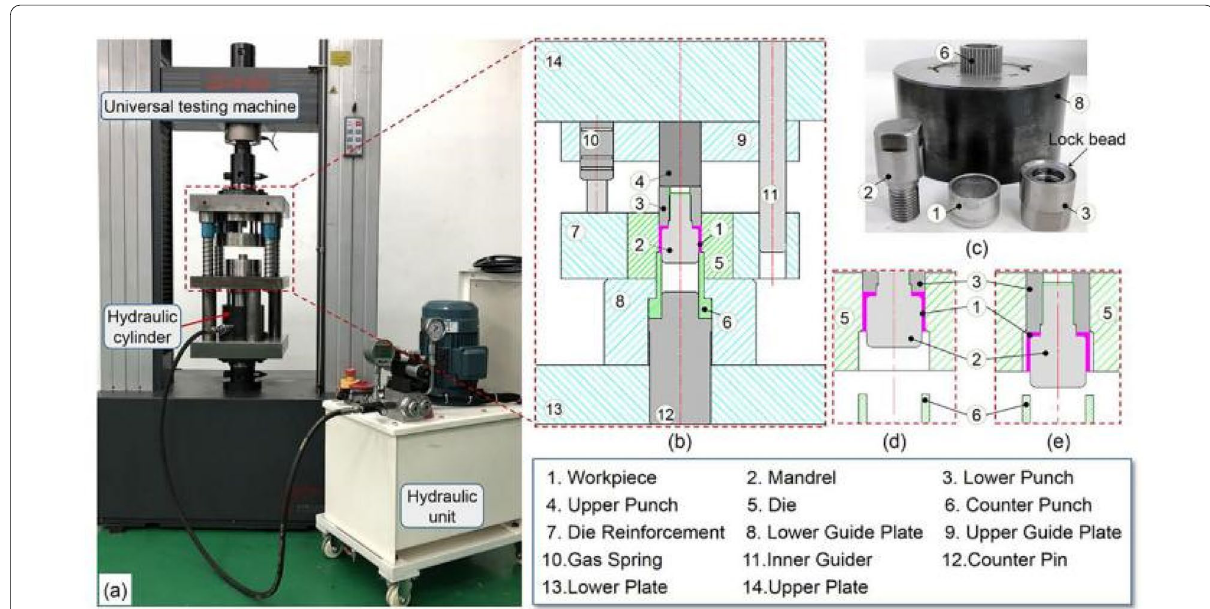
consistent with the experimental conditions, as shown in Figure 8. The stroke of the punch in the U-CDZ method was denoted as S 1 , and in the conventional method, S 2